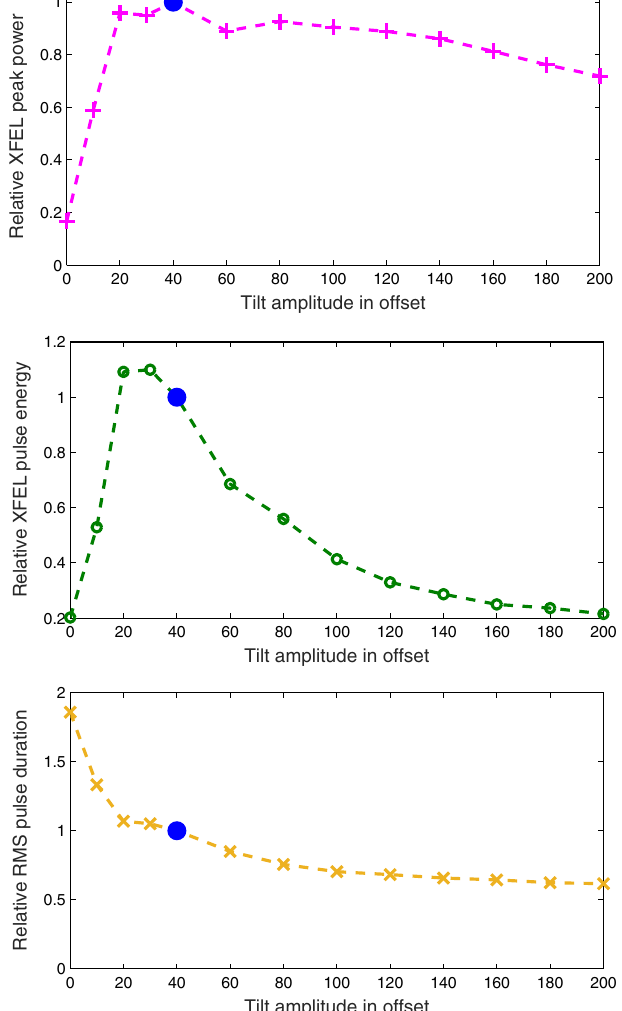
FIG. 6. Relative XFEL peak power (top), XFEL energy (center), and rms pulse duration (bottom) as a function of the initial tilt amplitude in offset. The simulations are done for the SwissFEL parameters with ten undulator sections (total of 15 undulator modules). The reference case (100% relative power, energy and length) corresponds to the optimum case in terms of XFEL power and is indicated by a blue